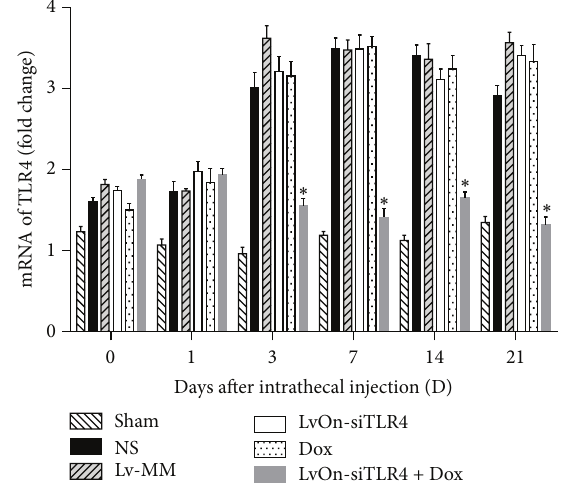
Figure 2: mRNA expression of TLR4 detected by real-time PCR. As shown in Figure 2, bone cancer in legs increased the TLR4 mRNA expression in the spinal cord in the five groups receiving Walker 256 cells injection. On the 3rd, 7th, 14th, and 21st days after delivery of Lv-siTLR4 with oral administration of doxycycline, the TLR4 mRNA expression decreased significantly in the Lv-siTLR4 with Dox group compared the other four groups receiving Walker 256 cells injection ( ∗ 𝑃 < 0.01 versus Lv-siTLR4 group, Lv-MM group, NS group, and Dox group, two-way ANOVO analysis followed by on the 1st day after